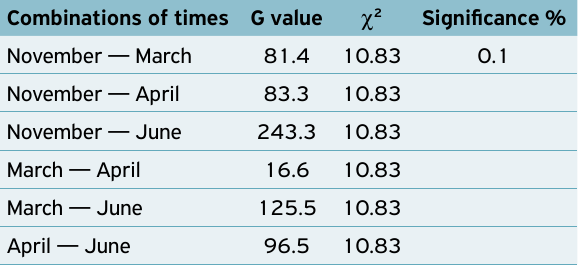
Table 4. Values calculated using the G test to compare survival curves.